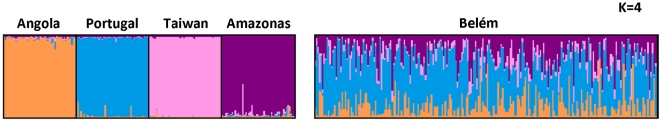
Ancestral membership proportions for testing population samples from different continental origins using the HGDP-CEPH diversity panel genetic data as training sets.Angola (Africa); Portugal (Europe); Taiwan (East Asia); Brazilian Amazonas tribes (Native America); Belém is an example of a highly admixed Brazilian city in northeastern Amazonas.